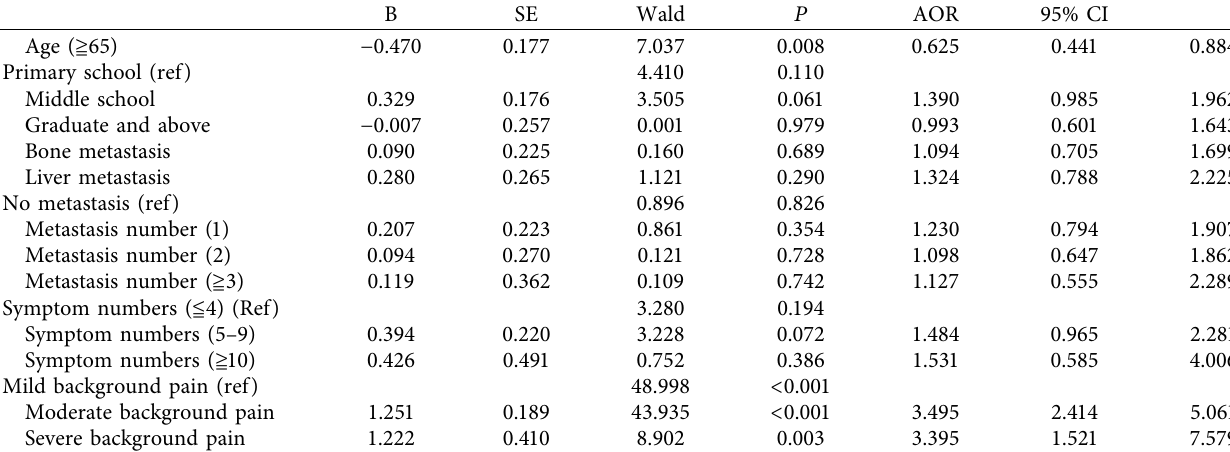
Table 4: Multivariate analysis for presence of